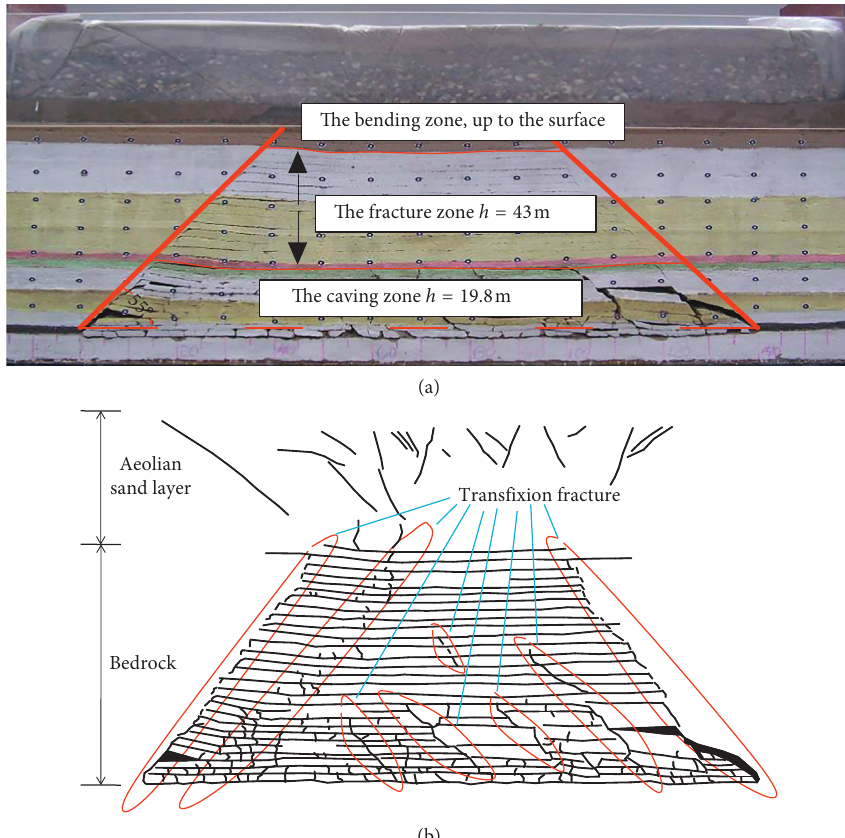
Figure 16: Overlying rock damage caused by coal seam mining. (a) Failure of overburden. (b) Distribution of rock fracture.